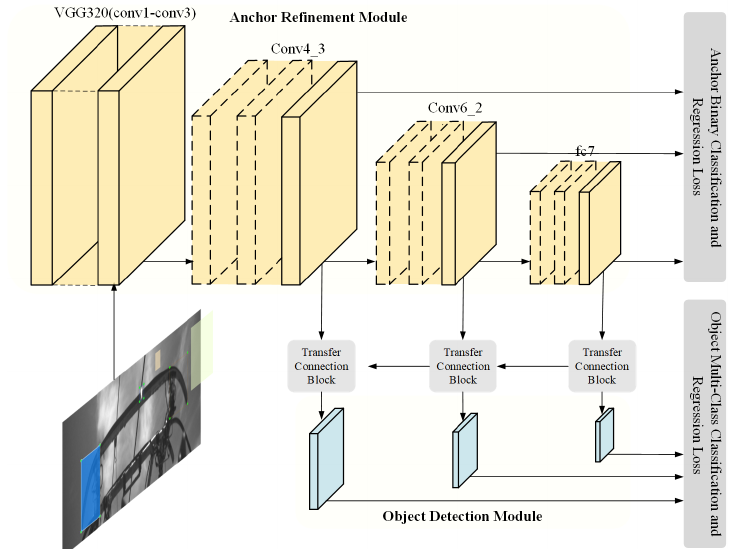
Figure 4. The pruned RefineDet network